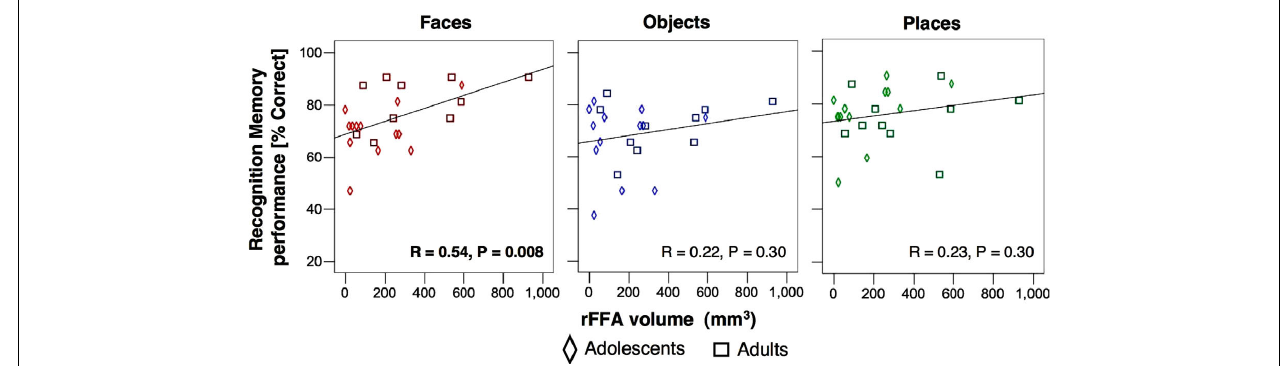
FIGURE 11 | Correlations between rFFA volume and recognition memory performance for faces ( Red ), objects ( Blue ) and places ( Green ). Diamonds : adolescents, n = 14 ages 12–16 years; Squares : adults, n = 11, ages 18–40